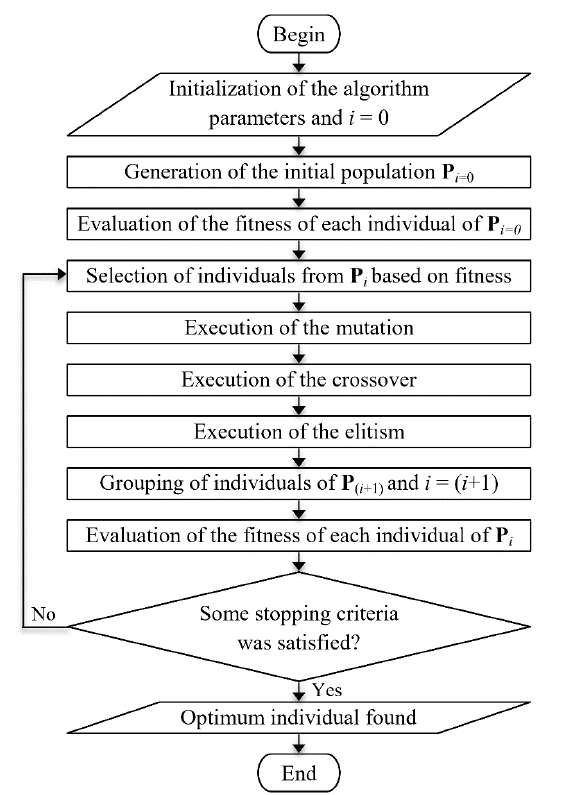
Figure 4. Basic scheme of a genetic